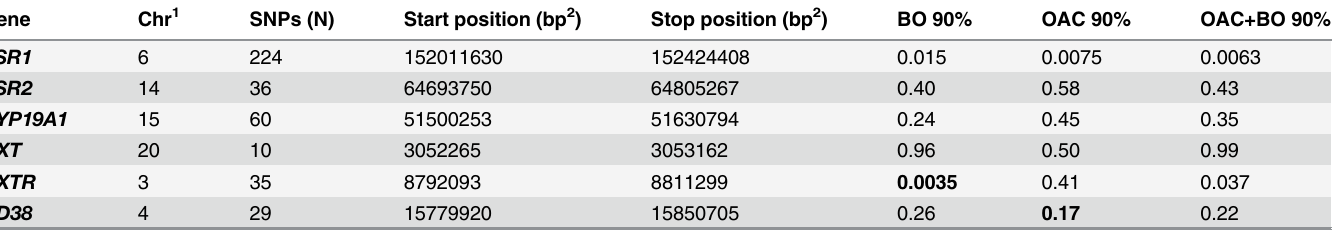
Table 4. Gene-based analysis of top 90% single nucleotide polymorphisms (SNPs) in genes known to regulate oestrogen levels and oxytocin lev- els and risk of Barrett ’ s oesophagus (BO), oesophageal adenocarcinoma (OAC), and these conditions combined (OAC+BO). P-values in bold are statistically significant after correction for multiple